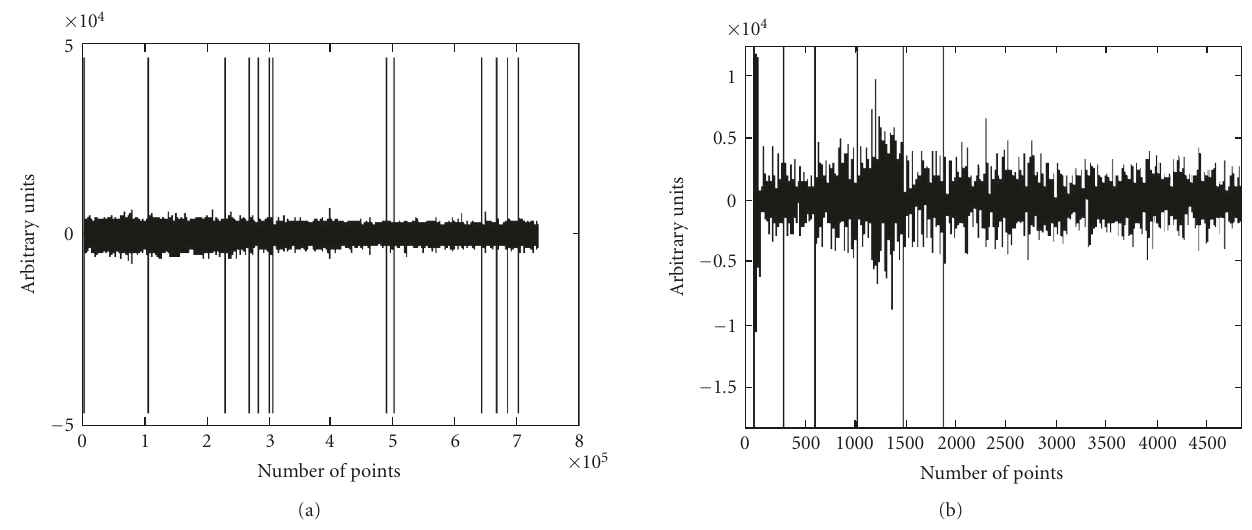
Figure 6: Application of MDCS on a real signal. (a) a 15-minute recording epoch, (b) zoom at the beginning of the signal. This figure shows the detection points. x -axis: number of points, y -axis: arbitrary units.